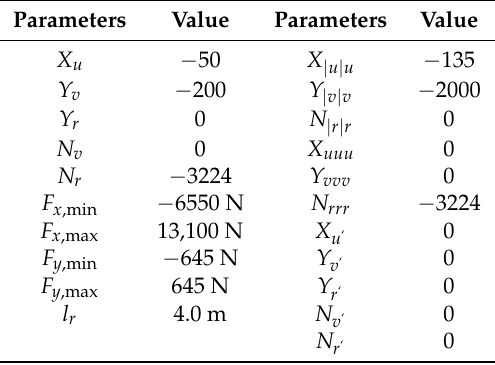
Table 2. Vessel Model